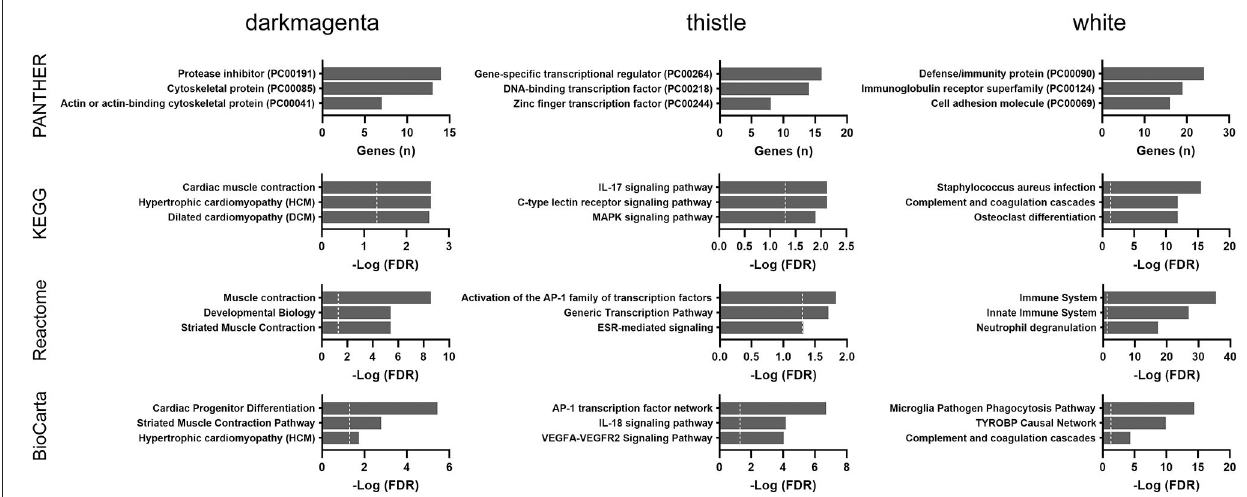
FIGURE 7 | Over-representation pathway analysis of three top-ranked WGCNA modules in the GTEx dataset: PANTHER protein class, KEGG, Reactome, and BioCarta. The top three classes or pathways are listed. Values above the dashed line represent significant enrichment (5% level of significance). FDR, false discovery